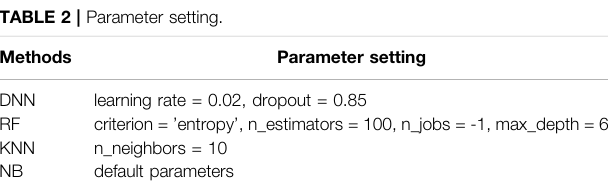
TABLE 2 | Parameter setting.